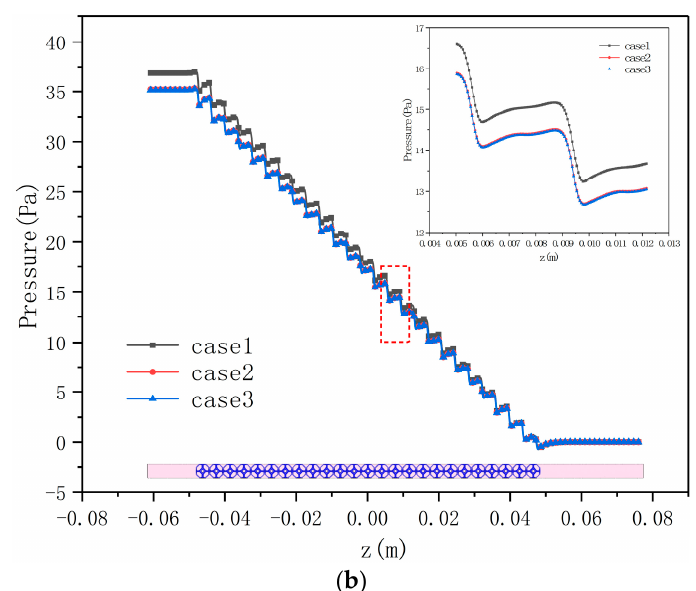
Figure 6. The velocity and pressure distribution along flow direction ( a ) velocity, ( b ) pressure.